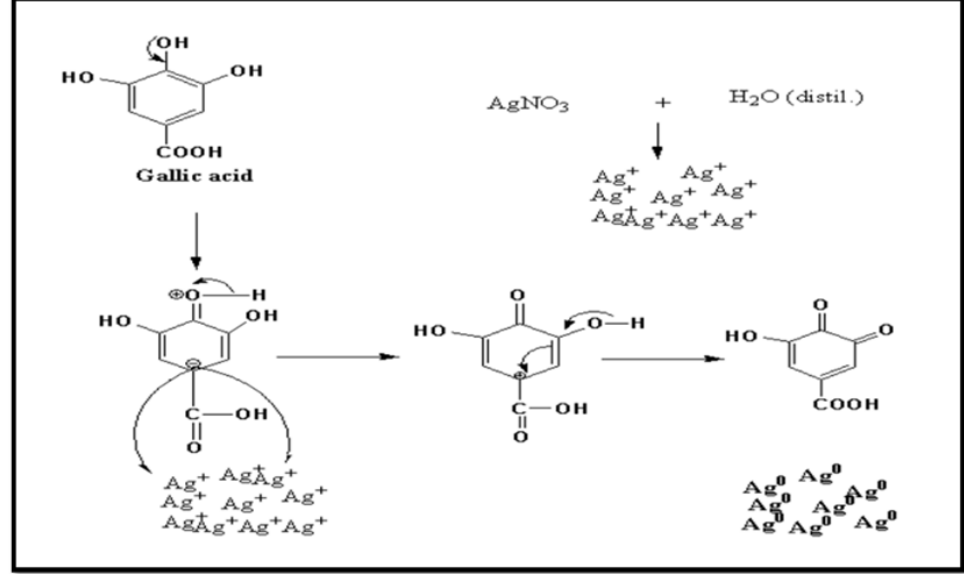
Figure 2. Mechanism for the reduction of AgNPs in presence of natural phytochemicals.